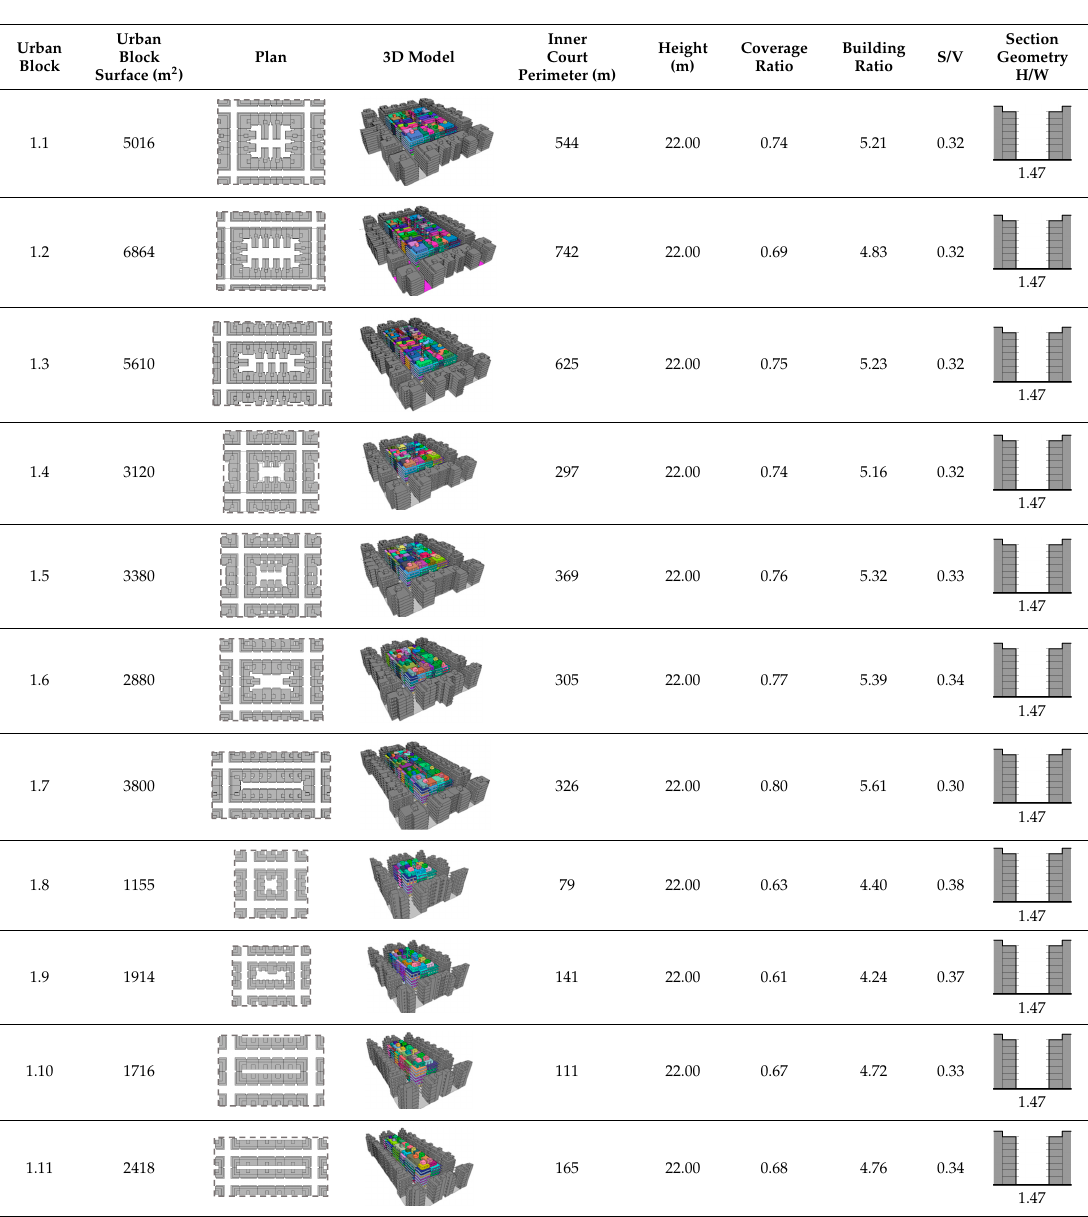
Table 1. Form and geometry parameters of typical urban blocks included in group 1.